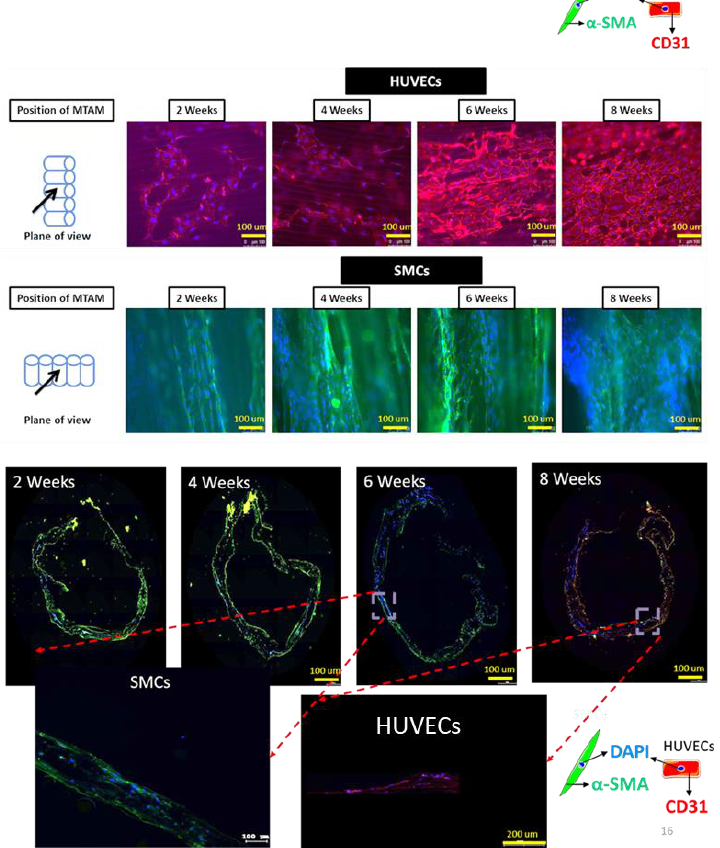
Figure 7. Fluorescence imaging (FM) of immunocytochemistry stained images of SMCs and HU- VECs co-cultured with PLGA MTAMs ( top ), and fluorescence microscopy imaging of transverse section of 2–8-week old tissue engineered vascular grafts ( bottom ). A monolayer of HUVECs were observed by week 8 of this study ( top , first row), while SMCs proliferated well along the direction of the lumen of the PLGA MTAMs ( top , second